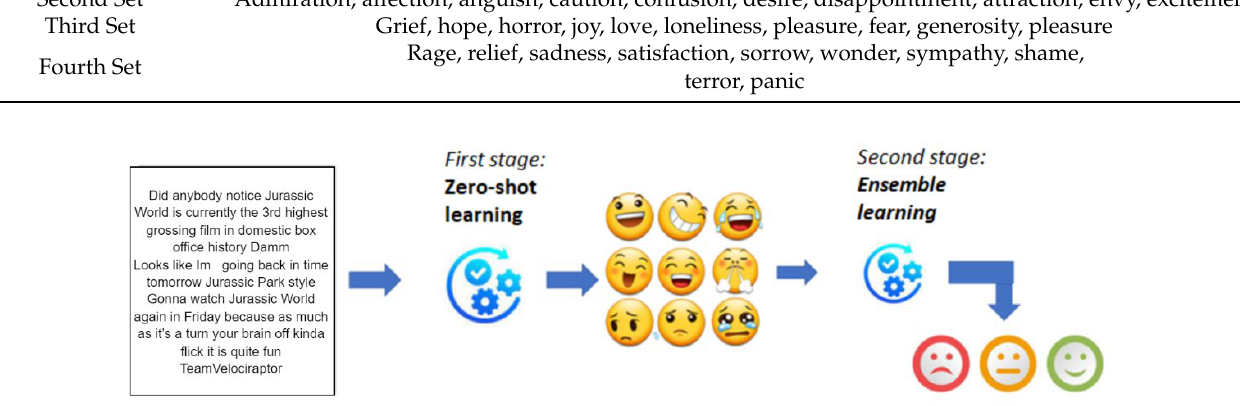
Figure 2. Two stages of the proposed semi-supervised method. The first stage uses unsupervised zero-shot learning by sentence transformers to obtain emotion probabilities. The second stage uses supervised ensemble learning to learn sentiments from emotion probabilities.